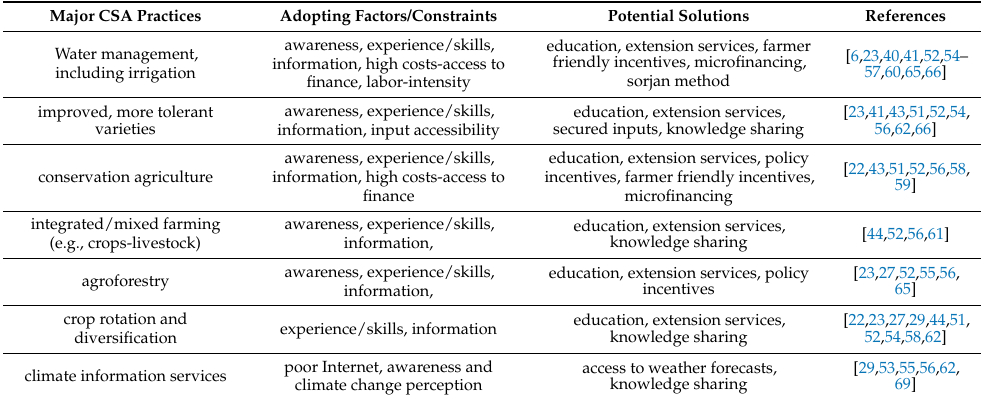
Table 2. Major characteristics of CSA